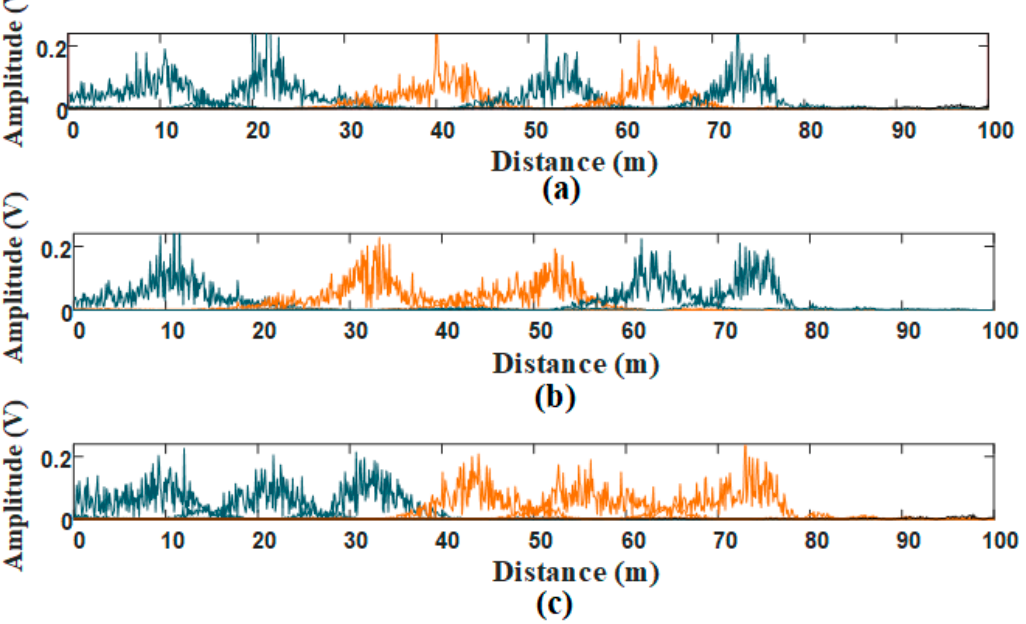
Figure 7. VDM processing with different parameters: ( a ) VMD parameters are α = 2000 and K = 7; ( b ) VMD parameters are α = 2000 and K = 5; ( c ) VMD parameters are α = 1000 and K = 7.